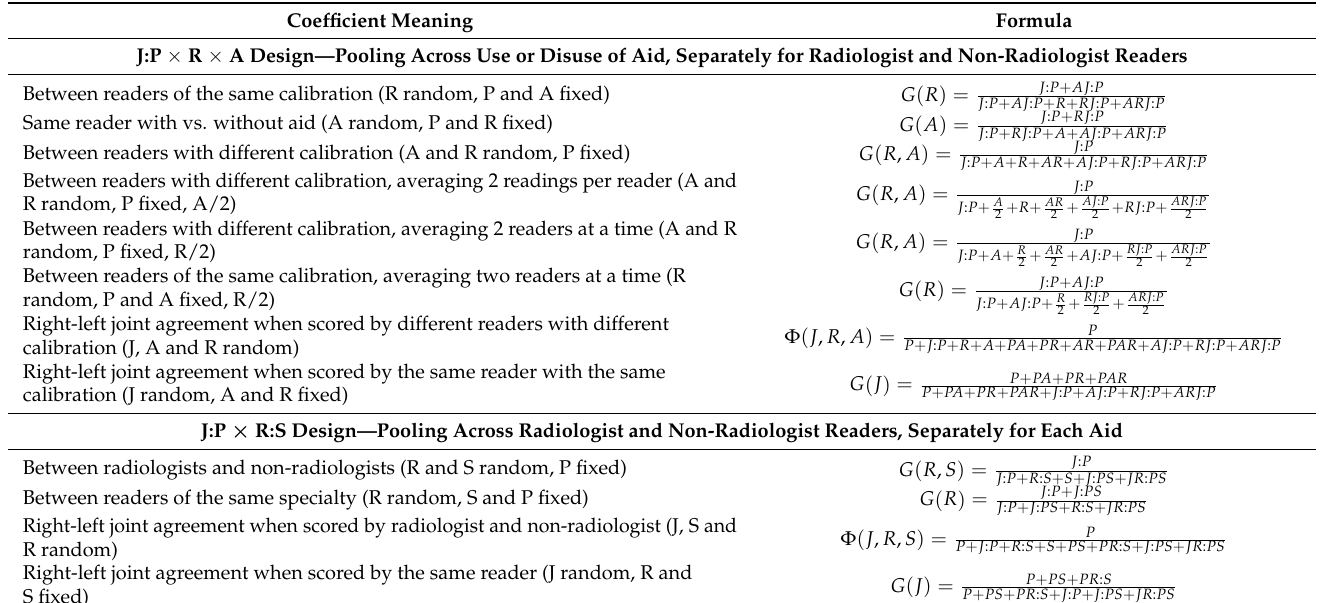
Table A3. Formulae used to calculate the G and Φ generalizability coefficients in Table 3, derived from references [20,21]. Abbreviations: A, aid or calibration level; J, temporomandibular joint; P, patient; R, reader; S, specialty (binary, radiologist or non-radiologist clinician); colon (:), nested relation, (e.g., J:P means joint is nested within the patient variable); cross (x), crossed relation (e.g., RxA means